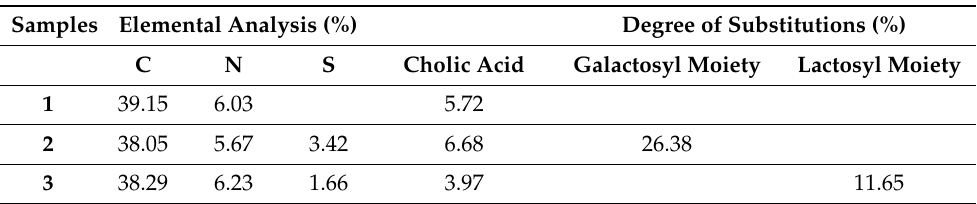
Table 1. Degrees of substitution of cholic acid, galactosyl fragment and lactosyl fragment in chi- tosan conjugates.